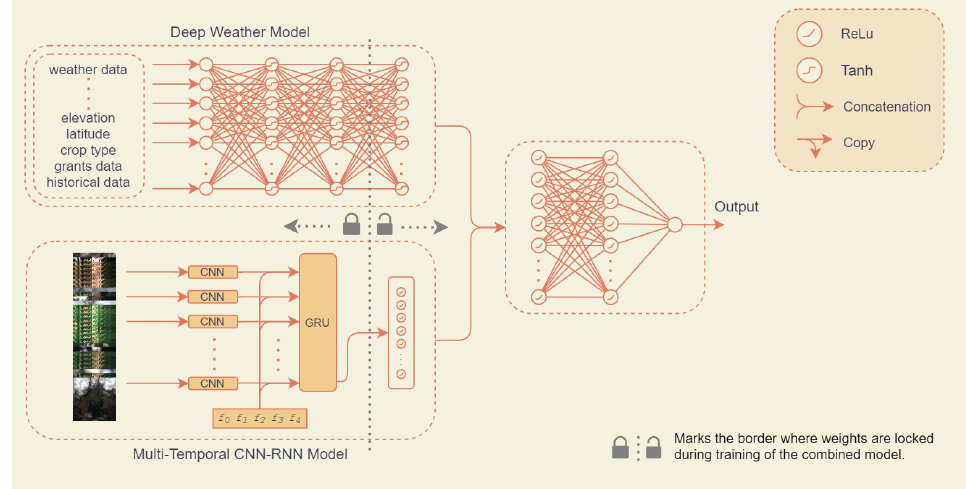
Figure 7. Novel approach 1: architecture of Pre-Trained Hybrid